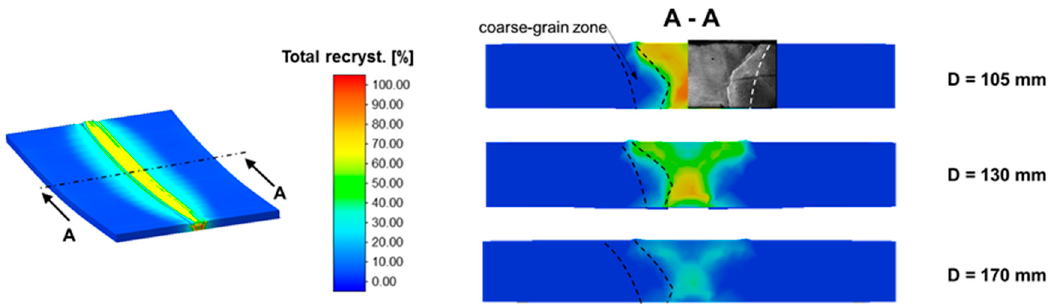
Figure 19. Fraction of total recrystallization depending on the distance between the torch and the roll.